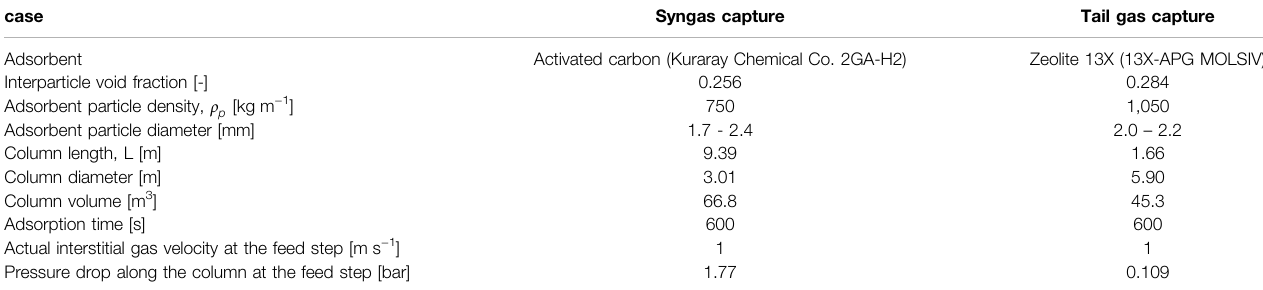
TABLE 2 | Physical properties of the adsorbents and adsorption column design data (Park et al., 2016; Park et al., 2021). case